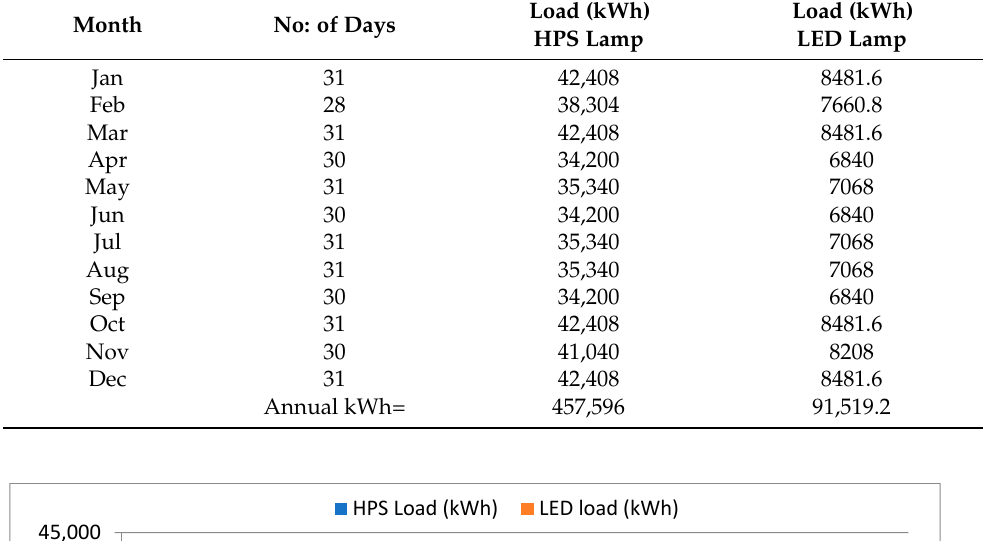
Table 3. Monthly load consumption of HPS lamp and 80W LED lamp.